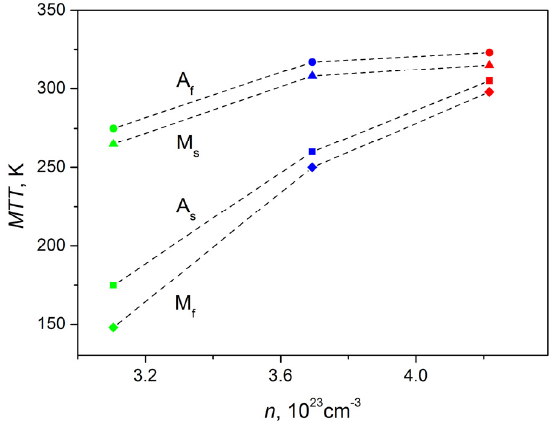
Figure 9. Dependences of the MTT on the concentration of current carriers: green symbols— Ni 45 Mn 43 In 12 , blue symbols—Ni 46 Mn 42 In 12 , red symbols—Ni 47 Mn 41 In 12 ; squares— A S , circles— A F , triangles— M S , rhombuses— M F .